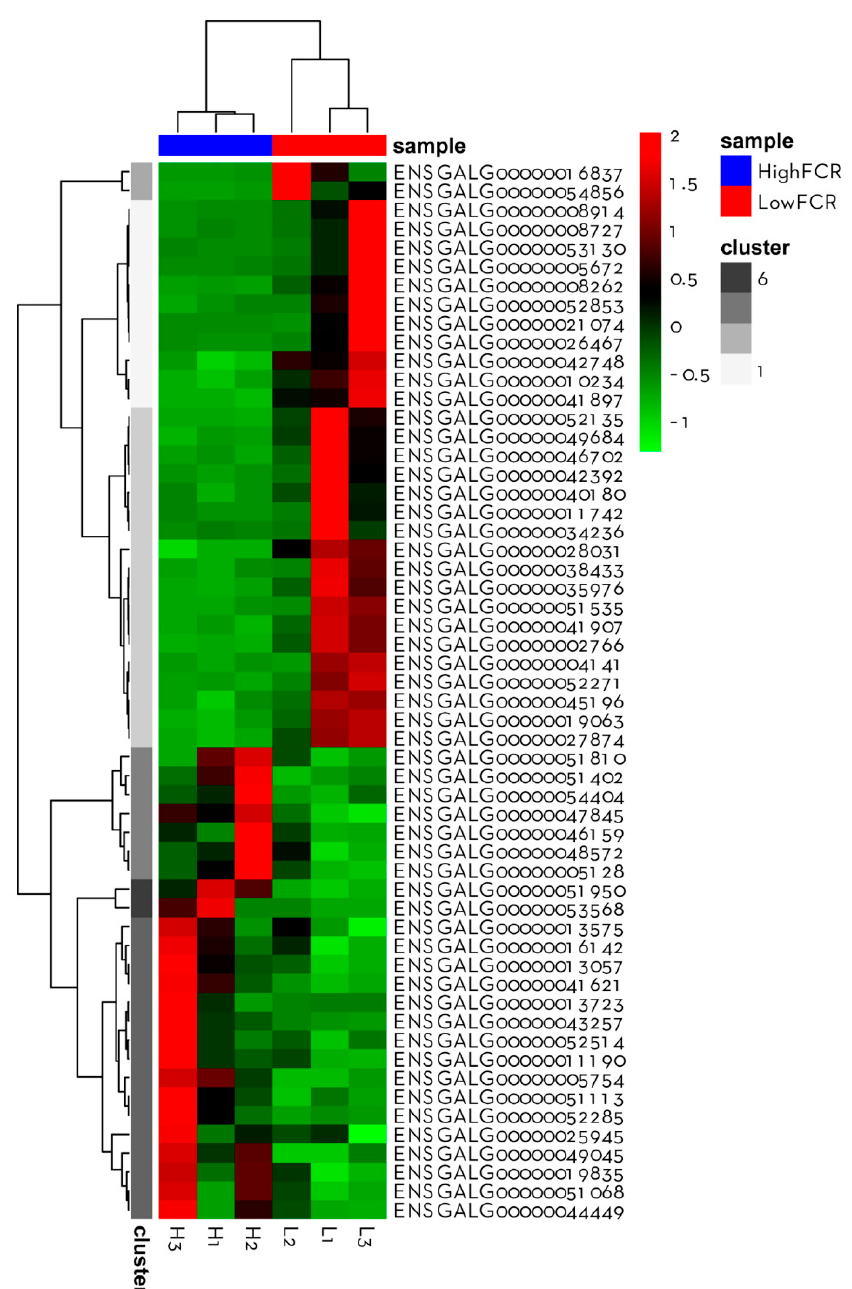
Figure 4. Heatmap featuring the gene expression profile of all genes associated with FCR. Each column represents an individual KR chicken, sorted by group (high- and low-FCR). Each row corresponds to a differentially expressed gene, and red and green colors indicate respectively higher and lower expression relative to average expression across all samples.